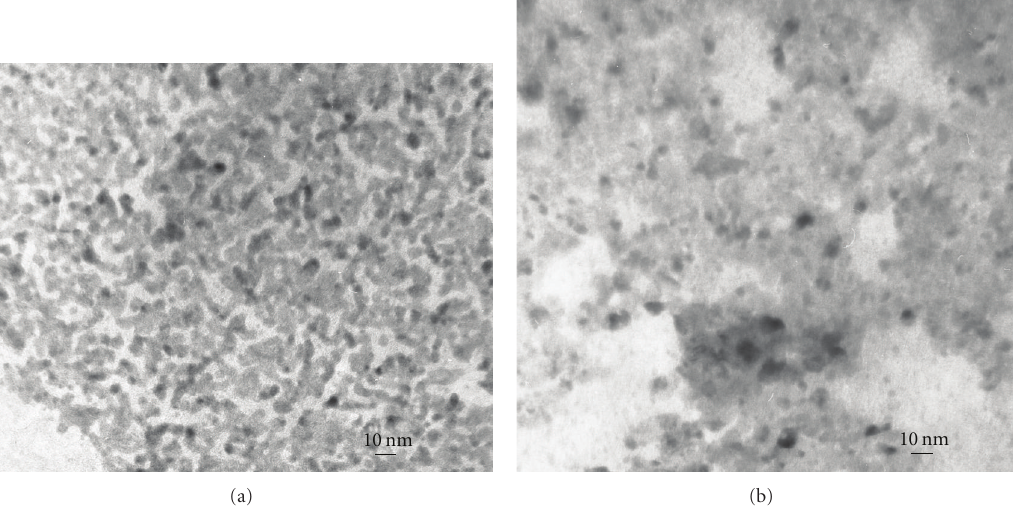
Figure 2: Transmission electron micrograph (TEM) images of ULPt(90s): (a) and ULPt(120s):